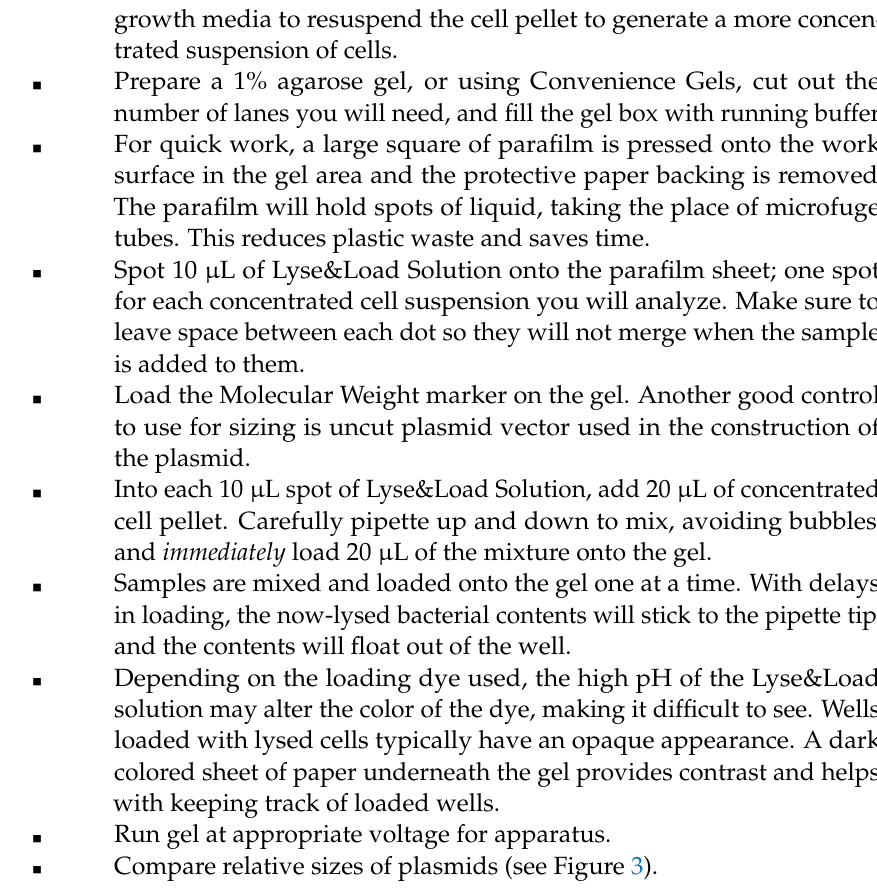
Table 1. Screening supercoiled, undigested plasmids by size. The size of each plasmid in Figure 3a is listed, along with the differences in absolute length (in base pairs) and % difference in length between the indicated plasmid and the one in the previous